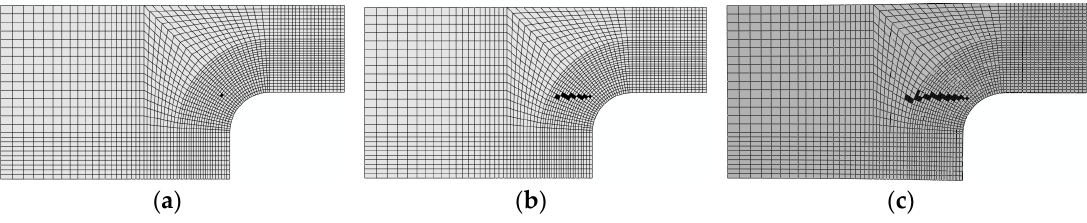
Figure 13. Matrix fracture damage of unrepaired fiber caused by transverse tension or shear ( − 45°):